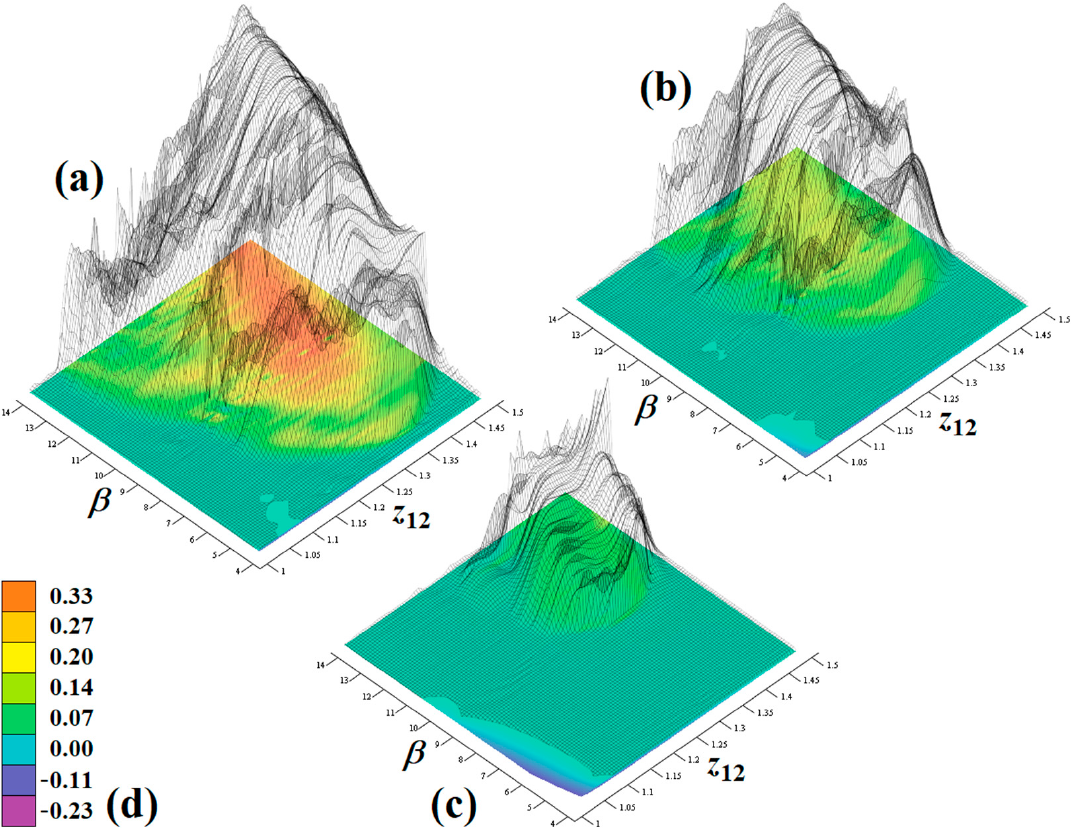
Figure 2. Rainbow-scaled surface-contour plot of the largest LE as function of principal system parameters: ( a ) z 22 = 1 Ω , ( b ) z 22 = 1.05 Ω , ( c ) z 22 = 1.1 Ω , ( d ) color legend valid for all plots.